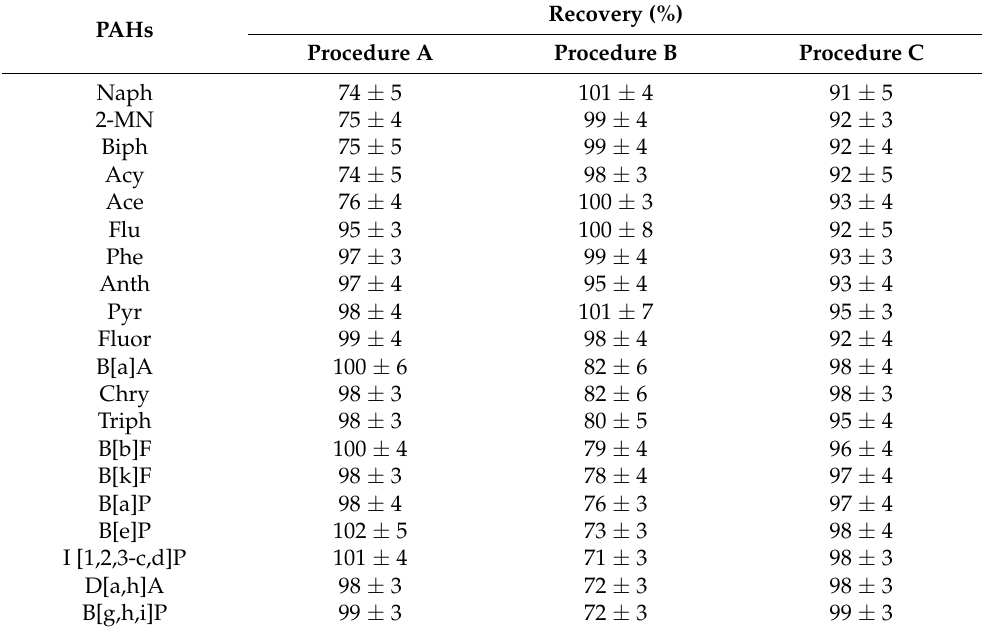
Table 2. The recoveries of PAHs by using different sample preparation procedures. Recovery (%) PAHs Procedure A Procedure